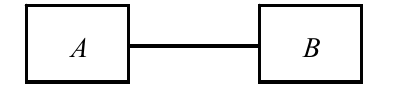
Fig. 1. Subsystems A and B are rigidly connected.